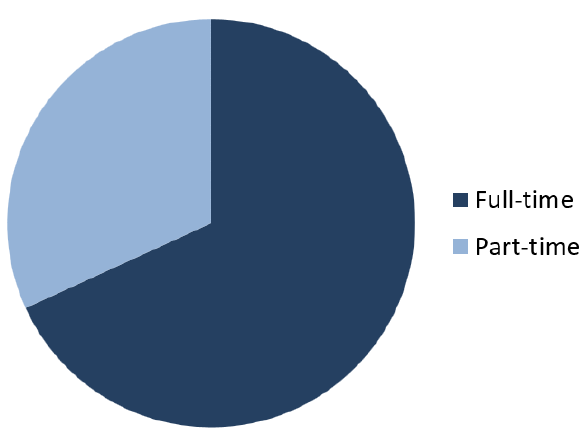
Figure 5. Share on content volume